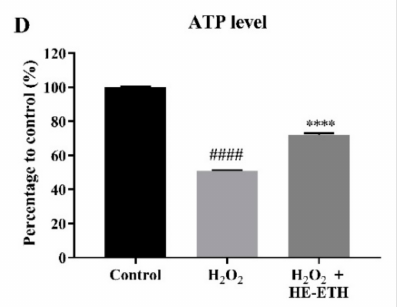
Figure 6. Improvement of mitochondrial functioning by ethanolic extract (HE-ETH) on H 2 O 2 -treated HT22 neurons. HT22 was co-incubated with 250 µ M H 2 O 2 and 400 µ g / mL HE-ETH before subjected to series of assays to assess mitochondrial functions. ( A ) Representative images of mitochondrial membrane potential (MMP) stained by tetramethylrhodamine ethyl ester (TMRE) with quantification of ( B ) MMP, ( C ) mitochondrial toxicity and ( D ) ATP level. All values presented correspond to mean ± SD of triplicates ( n = 3). Values of ## p < 0.01; #### p < 0.0001 compared with control, and * p < 0.05; *** p < 0.001; **** p < 0.0001 compared with H 2 O 2 -treated group were considered as statistically significant. Scale bar denotes 100 µ m.